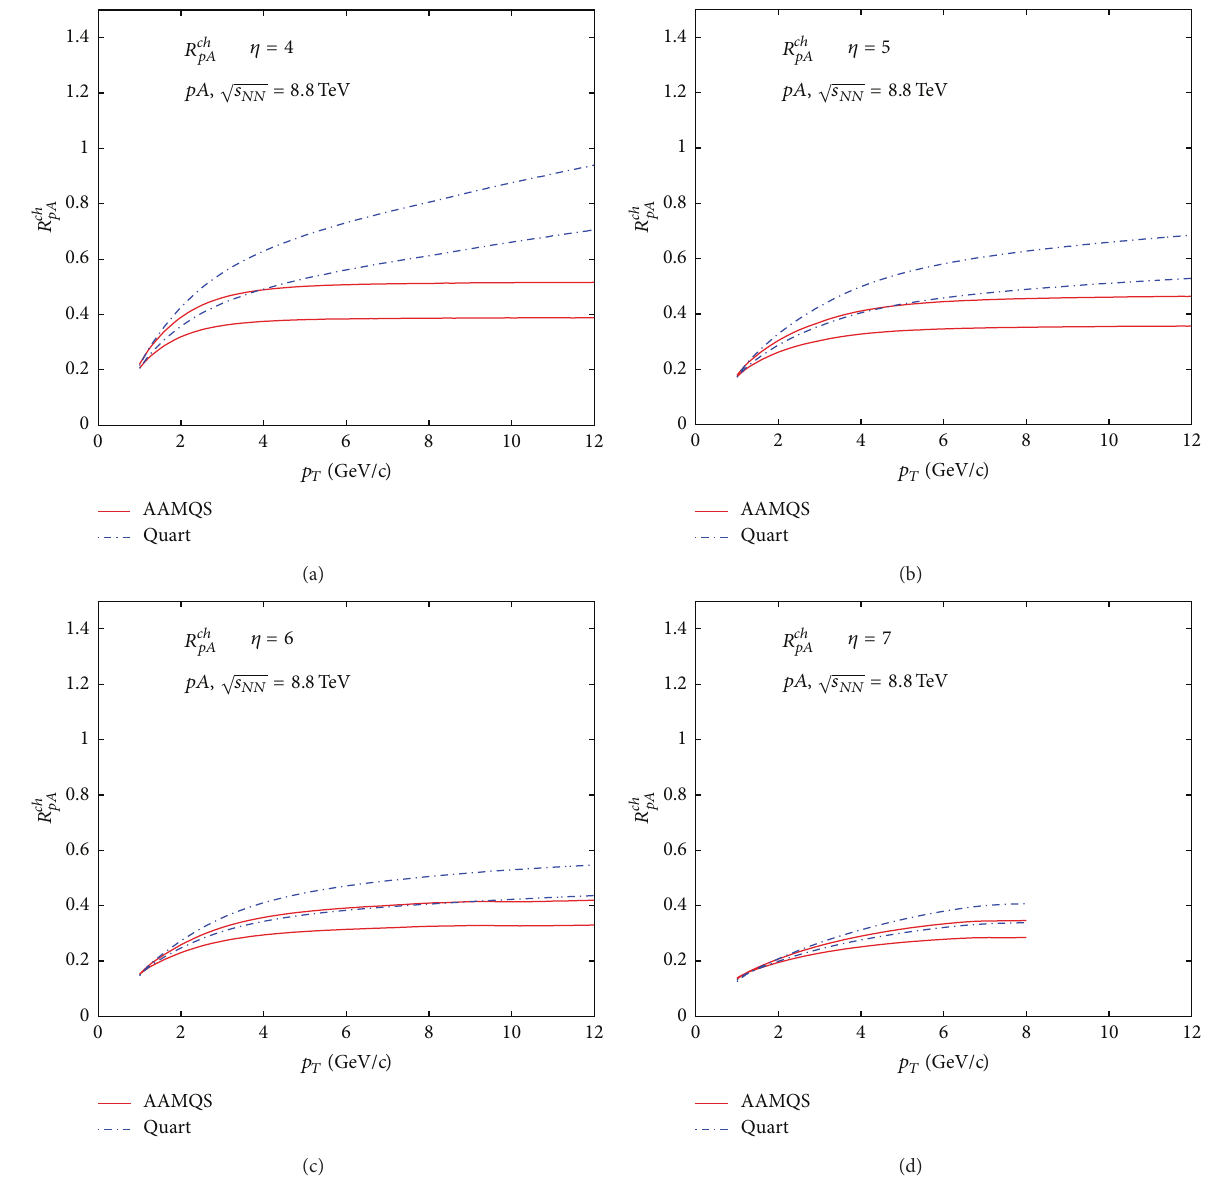
Figure 9: Same as Figure 8, but for the results at √𝑠 𝑁𝑁 = 8.8